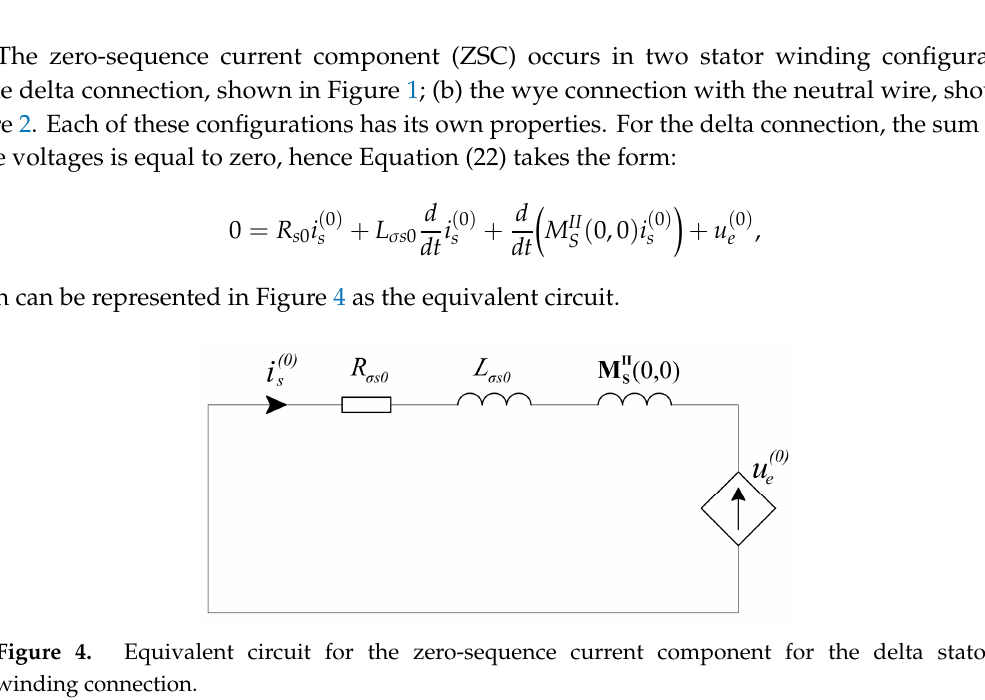
Figure 4. Equivalent circuit for the zero-sequence current component for the delta stator winding connection.